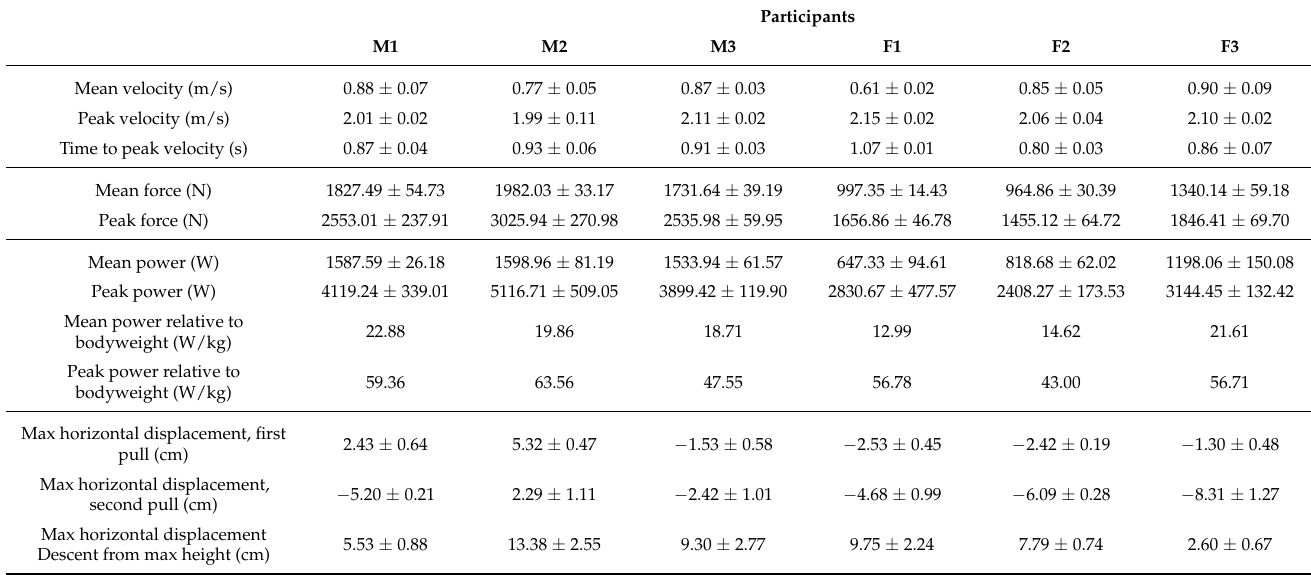
Table 2. Snatch performance variables of the male and female